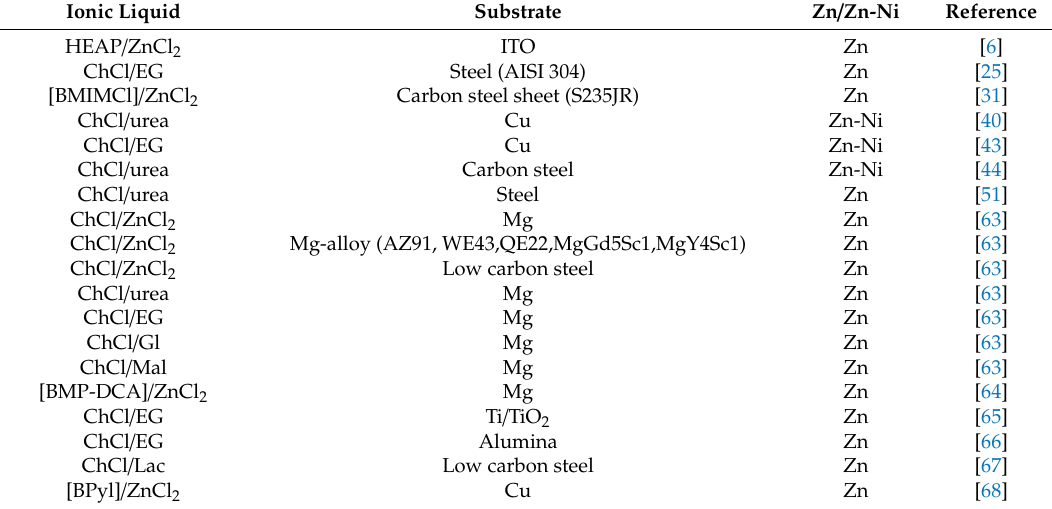
Table 4. The Zn deposition in di ff erent ionic liquids on di ff erent substrates. Ionic